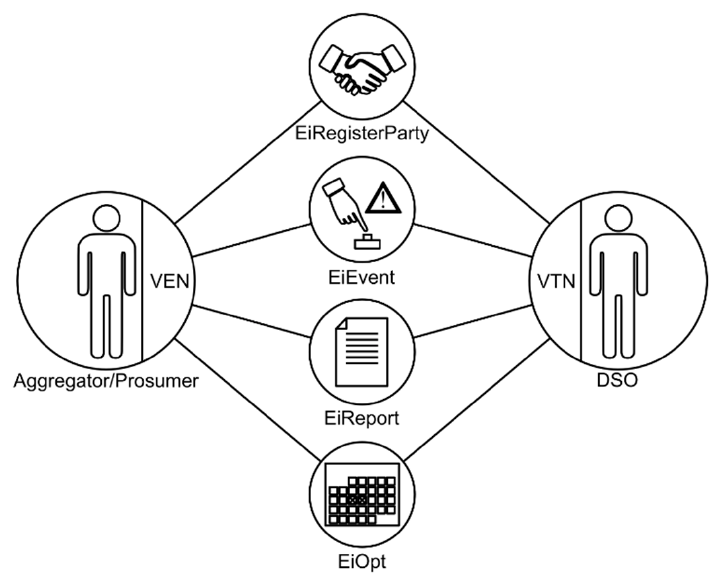
Figure 3. OpenADR communication services.